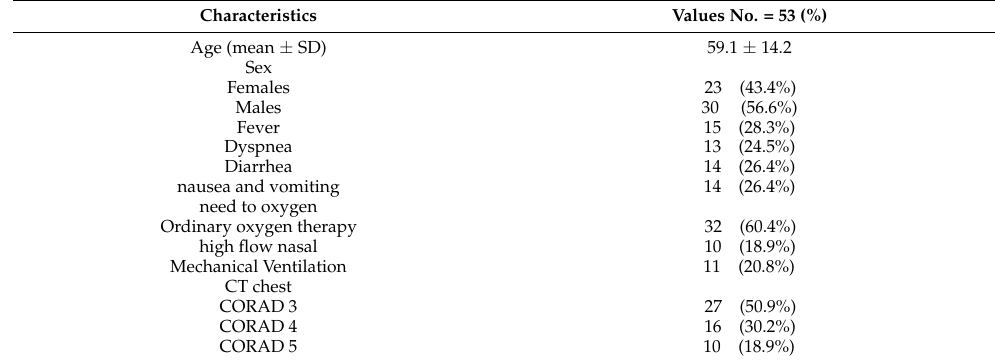
Table 1. Characteristics of the studied patients and disease characteristics of COVID-19 (symptoms and